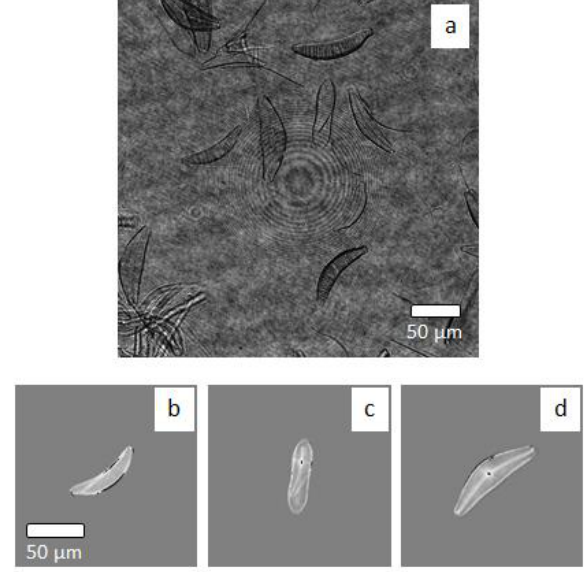
Figure 5. Examples of holographic images of live diatoms. ( a ) one of the recorded digital holograms of diatoms mixed in a petri dish. ( b ) class 27 ( c ) class 41 ( d ) class 42. Each class correspond to diatoms species. ( b – d ) Phase-contrast map are shown. Diatoms belonging to these three classes have similar morphological features and are used to carry out the